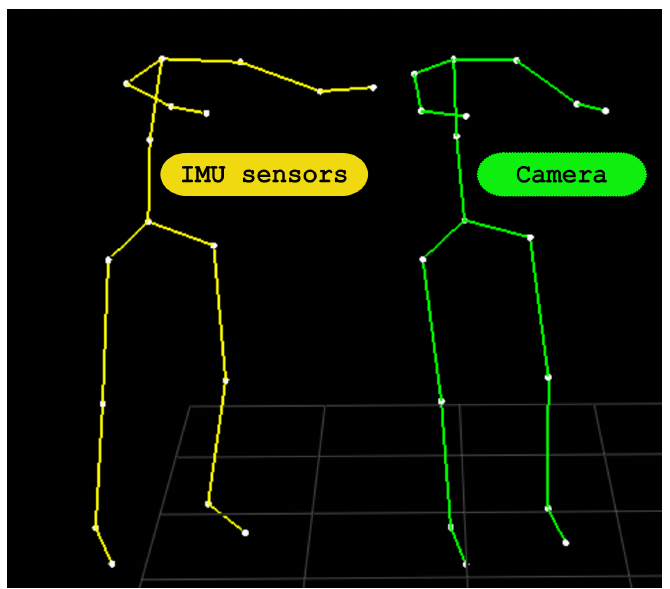
Figure 10. Human body models reconstructed from IMU sensor clothing (left) and BTS SMART DX camera system (right). Sacrum used for the base point.